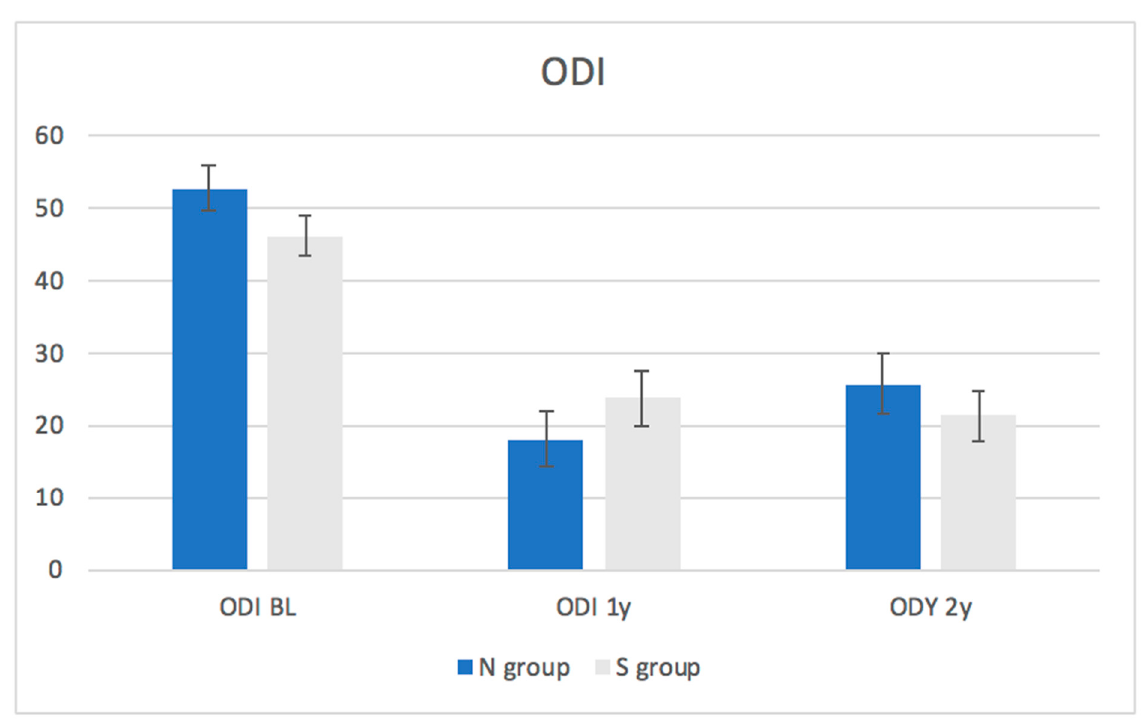
Figure 1. Changes in the Oswestry Disability Index (ODI) within in each group throughout the follow-up period.